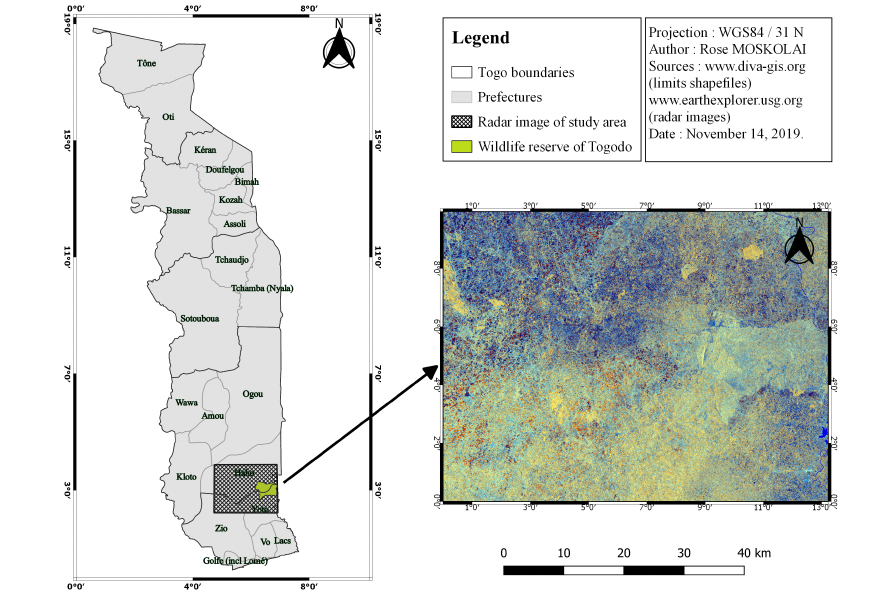
Figure 3. Location map of the Wildlife Reserve of